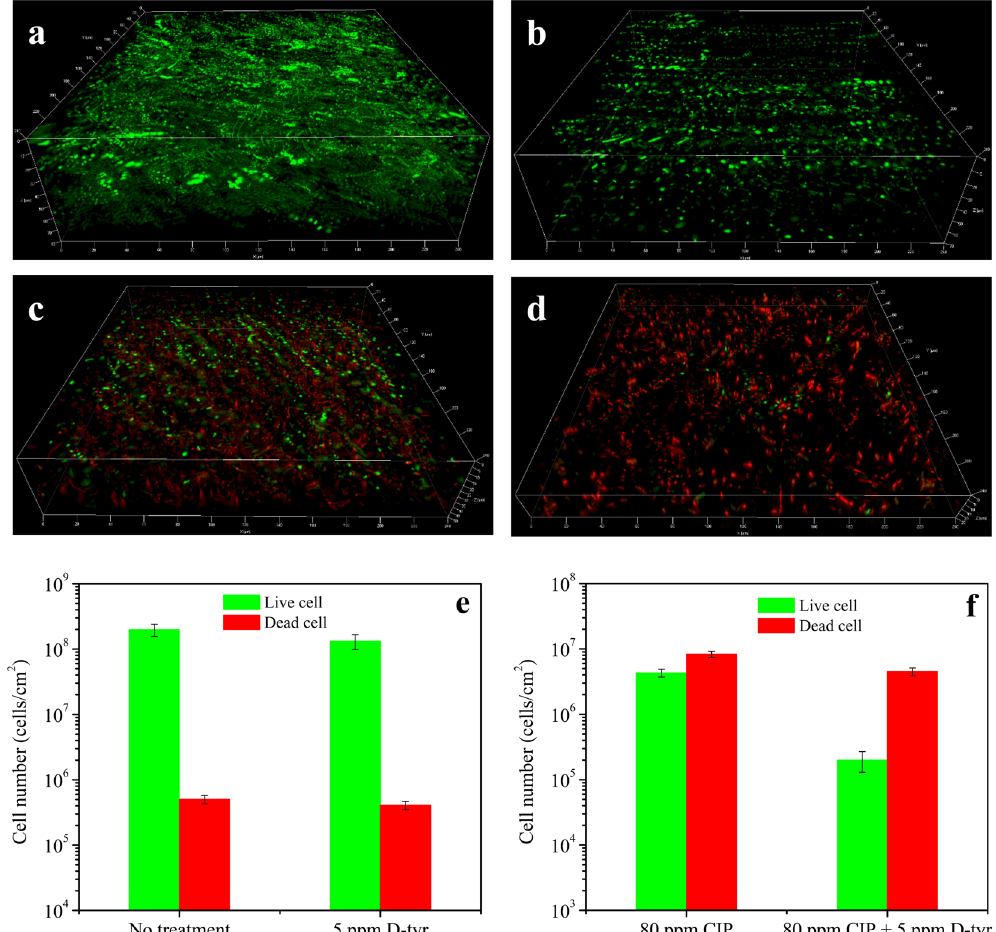
Figure 7. CLSM images of PA biofilms (Dimensions: X = 224 µ m, Y = 224 µ m) after the 3-hour biofilm removal test in the pH 7.4 PBS buffer containing: ( a ) no treatment (control) (biofilm thickness = 72 µ m), ( b ) 5 ppm D-tyr (biofilm thickness = 69 µ m), ( c ) 80 ppm CIP (biofilm thickness = 49 µ m), and ( d ) 80 ppm CIP + 5 ppm D-tyr (biofilm thickness = 28 µ m). The calculated numbers of live/dead cells are shown in ( e ) and ( f ). (Error bars represent standard deviations, statistical reference point n =